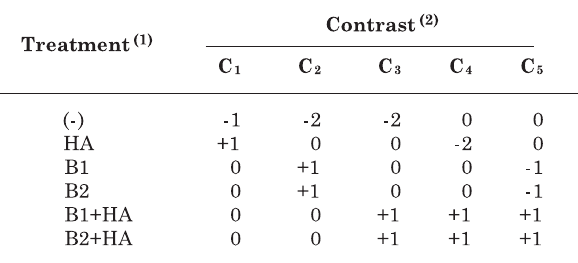
Table 1. Contrast coefficients for the treatments: control, humic acid, bacteria, bacteria and humic acid